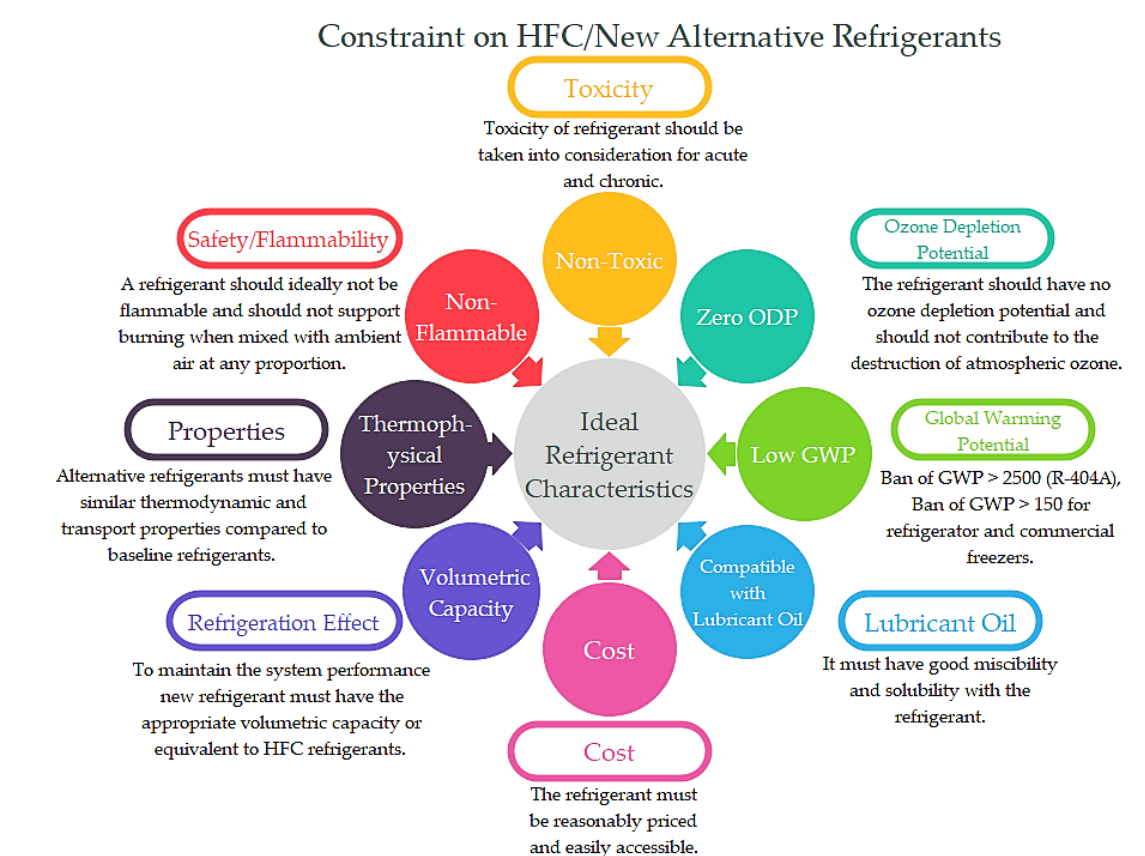
Figure 1. The ideal characteristic of environmentally benign refrigerants. Condensation is the major heat transfer process in the typical condensers of HVAC systems; effective condensation can well control the system pressure and manage the heat transfer to system efficiency. Conversely, inadequate condensation can reduce the system performance and yield high pressure that may damage the whole system. Therefore, con- densing heat transfer characteristics of the working fluid is equally important as boil- ing/evaporation heat transfer characteristics in the HVAC systems. With the advent of new fourth-generation HFO low-GWP refrigerant, there are numerous studies regarding the condensing heat transfer performance of low-GWP refrigerants which have been re- ported in the past decades. A thorough analysis of condensation investigations inside mi- crochannels from the previous two decades was presented by Kadi et al. [2]. Fronk and Garimella [3] reviewed the in-tube condensation of zeotropic fluid mixtures. Ho and Leong [4] critically reviewed film-wise natural/forced convection condensation on en- hanced surfaces which mostly focused on HFC refrigerants. Mauro et al. [5] reviewed the flow pattern, condensation, and boiling inside and outside smooth and enhanced surfaces of propane (R-290) only. Shon et al. [6] reviewed the condensation and evaporation char- acteristics of low-GWP refrigerants in plate heat exchangers. Tao and Ferreira [7] re- viewed the heat transfer and frictional pressure drop during condensation in plate heat exchangers. The aforementioned literature reveals that previously reviewed articles are limited in some manners such as working fluid (refrigerants) [5], condensation inside the tube [3] and microchannels [2], condensation inside/outside on the enhanced surface [4], and a plate heat exchanger [6,7]. Therefore, the major goal of this review is to examine the con- densation heat transfer and the frictional pressure drop characteristics for low-GWP re- frigerants focused on R-134a alternatives subjected to the outside/inside of a smoot/en- hanced tube, inside minichannels, and brazed plate heat exchangers. In addition, the